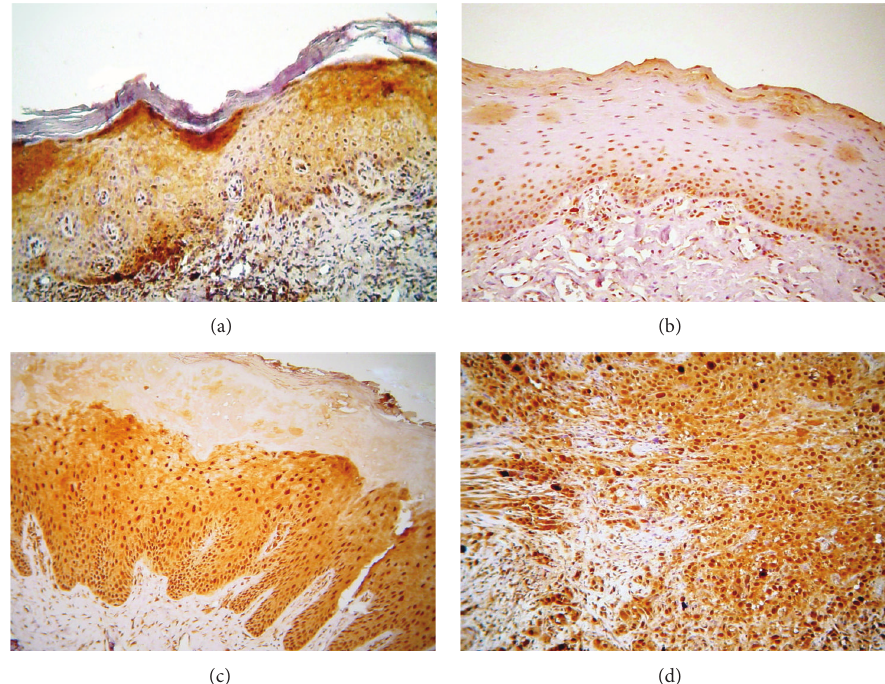
Figure 1: Immunohistochemical expression of phosphorylated Akt at serine 473 (p-Akt) in selected cases of (a) oral lichen planus (OLP), (b) normal mucosa (NM), (c) oral leukoplakia (OL), and (d) oral squamous cell carcinoma (OSCC) (immunohistochemistry, 100x magnifications). Table 1: Percentage of positive cases and average positivity, intensity, and total scores for nuclear p-Akt per lesion category. Number and % of positive cases Average positivity score Average intensity score Average total